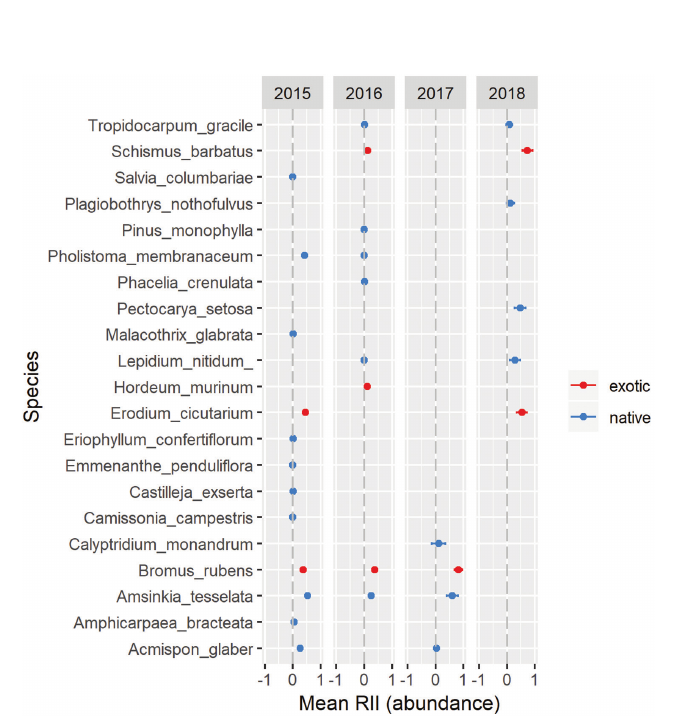
Table 2. Mean effects (RII ± SE) of shrubs on annual species at the provenance level. RII values are sum- marised across native (RII ) and exotic (RII ) annual species for each year of the study (2015–2018) native exotic and for all study years combined (Net). P ≤ 0.05 indicates that RII values differ at the provenance level, according to independent generalized linear models (2015–2018) and a linear mixed-effects model (Net).